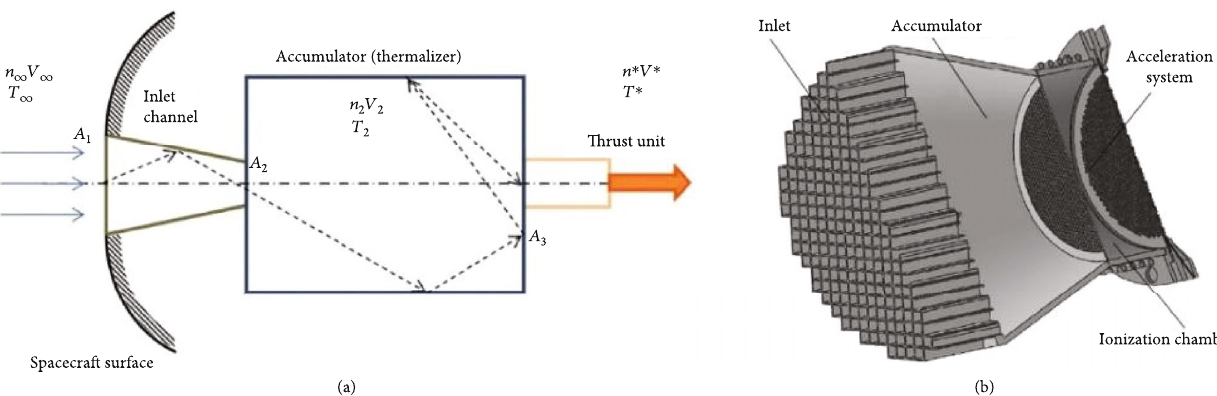
Figure 28: Erofeev ’ s ABREP: (a) principal block-diagram of ABREP thruster; (b) 3D model of ABREP thruster